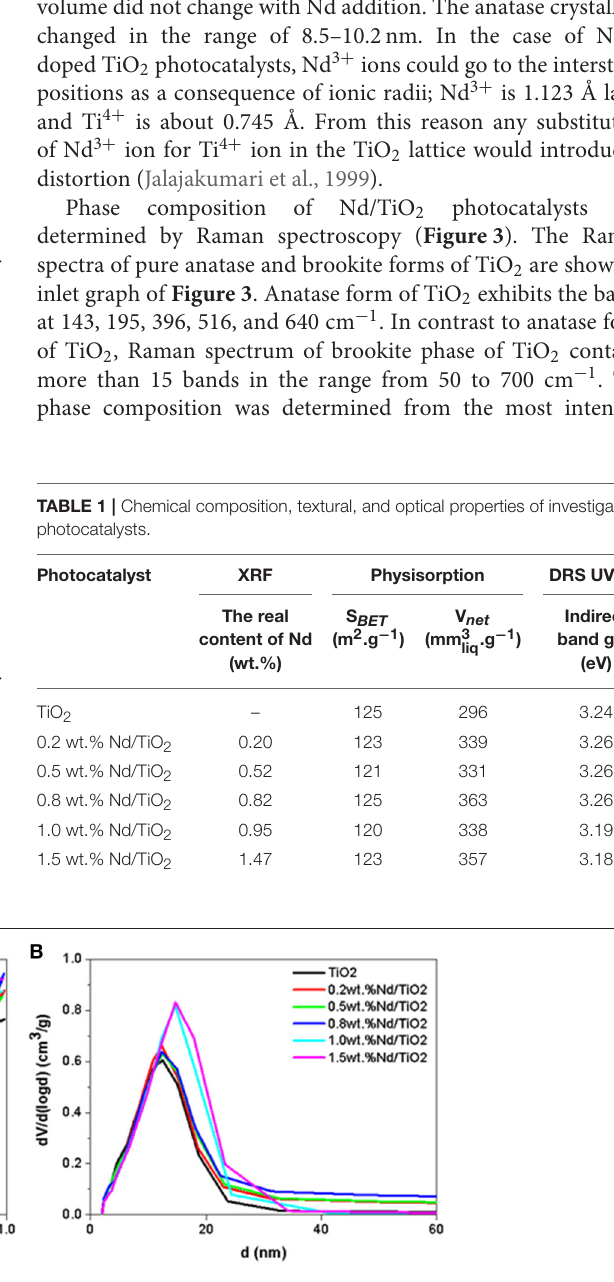
FIGURE 1 | (A) Measured nitrogen adsorption-desorption isotherms and (B) evaluated pore-size distributions of investigated photocatalysts.